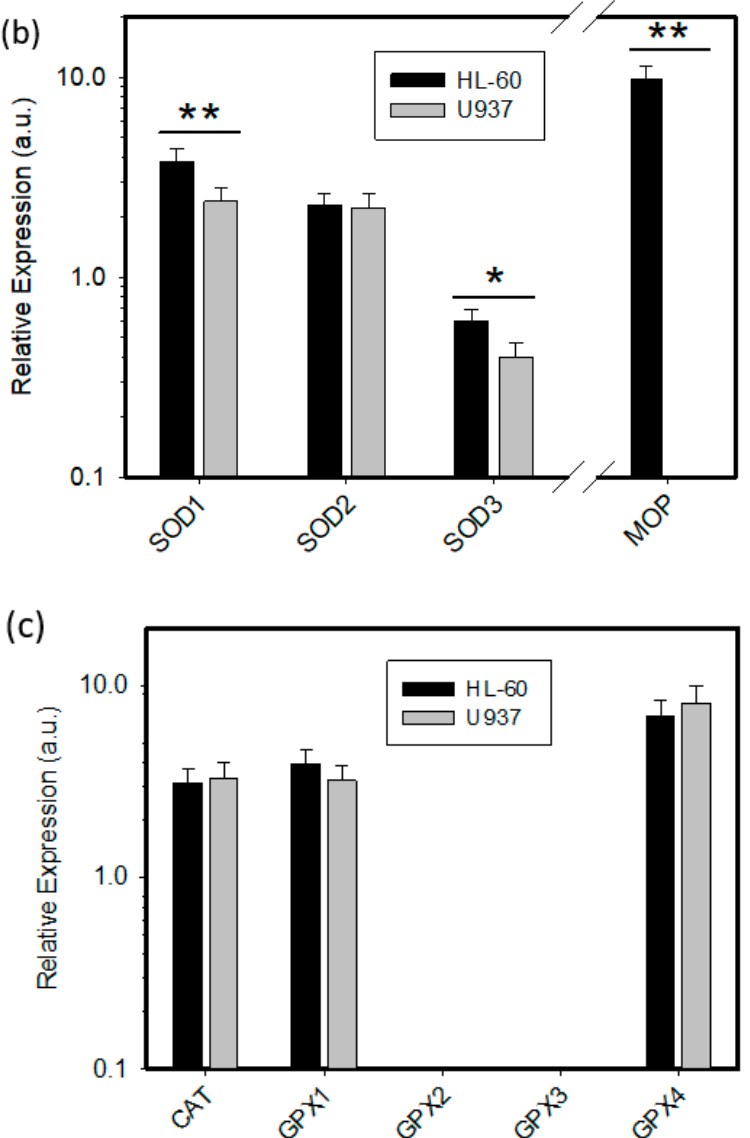
Figure 5. Analysis of the mRNA expression of ROS-related genes in HL-60 and U937 cells. ( a ) Ex- pression analysis of NOX1 – NOX5 genes. ( b ) Expression analysis of SOD1 – SOD3, and MPO genes. ( c ) Expression analysis of CAT and GPX1 – GPX4 genes. Results represent the mean values of four independent experiments with standard errors. */** denotes significant/very significant difference in the relative expression of appropriate ROS-related gene ( p < 0.05/ p < 0.01) between HL-60 and U937 cells.